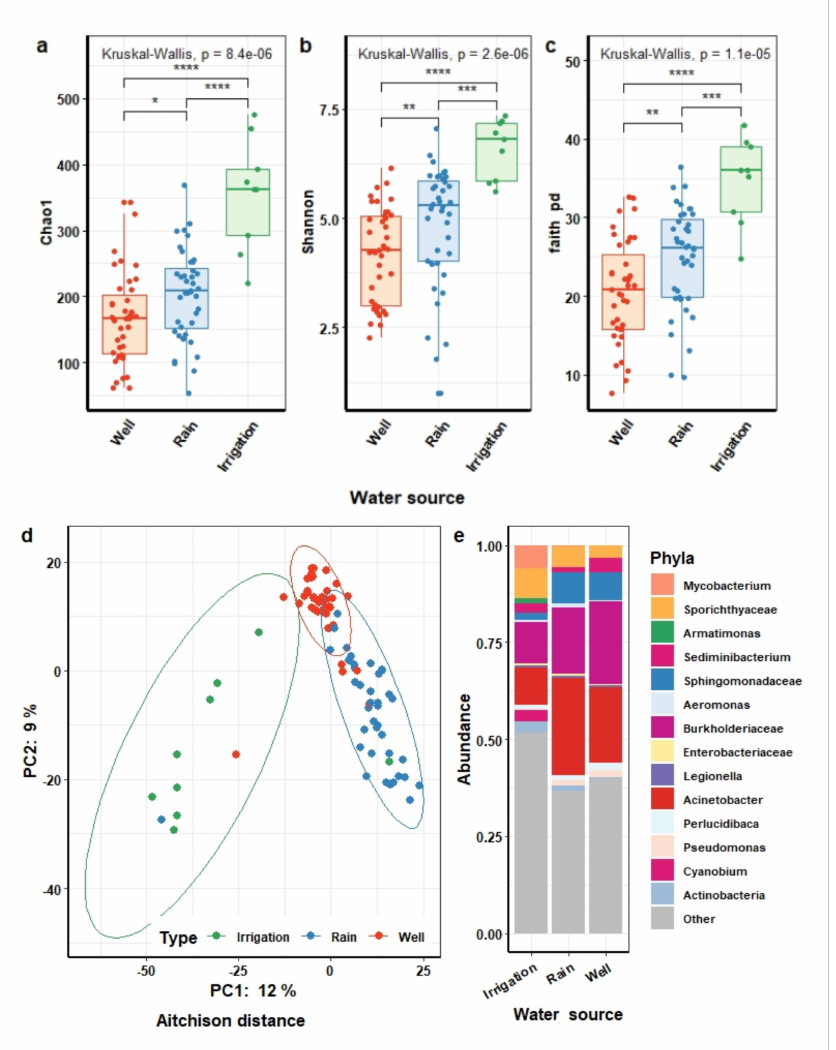
Figure 5. Microbial richness, diversity, community structure, and dominant taxa of different water sources. Differences in microbial richness (Chao1) ( a ) and diversity (Shannon ( b ) and Faith’s PD ( c )) of different water sources compared by Wilcoxon tests. Difference is significant at FDR q -value < 5 × 10 − 2 . ( d ) Ordination of the microbiota community structures of water samples based on principal component analysis of Aitchison distance (PERMANOVA test, FDR q -value < 5 × 10 − 2 ). Each point represents the microbiota community structure of well (red), irrigation water (green), and rainwater (blue), respectively. ( e ) The relative abundance of major bacterial genera in different water sources. Symbols show the statistical significance levels, ns indicates p ≥ 5 × 10 − 2 , * indicates p < 5 × 10 − 2 , ** indicates p < 1 × 10 − 2 , *** indicates p < 1 × 10 − 3 , **** indicates p < 1 × 10 − 4